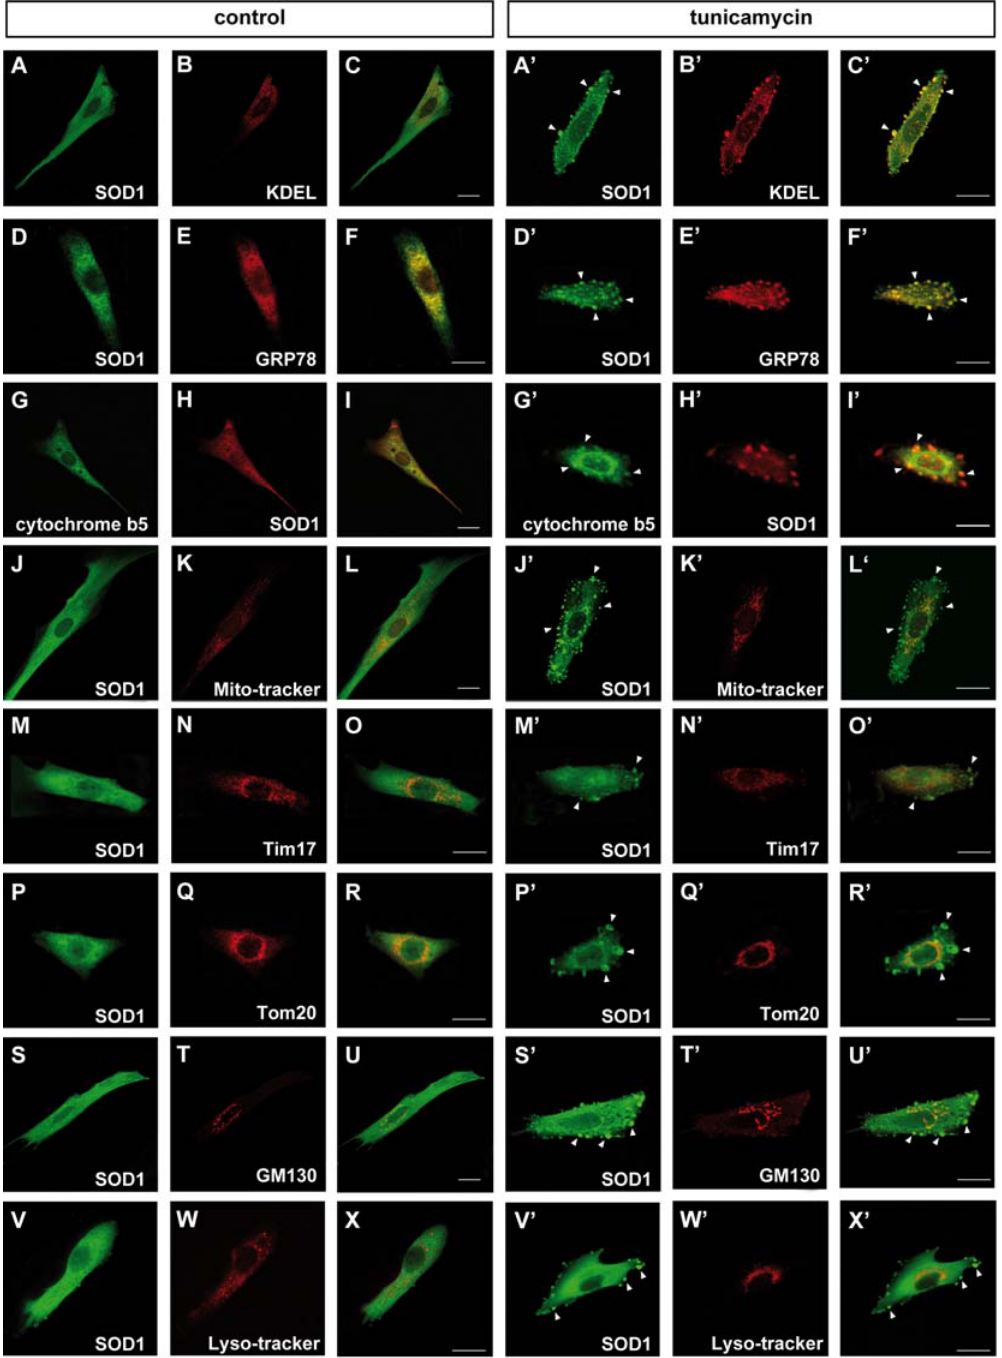
Figure 3. Positive translocation of SOD1 aggregates to ER, but not to the mitochondria, Golgi apparatus, or lysosomes. ( A–I, A 9 –I 9 ) Stress- dependent localization of SOD1 to the ER. L84V SOD1-expressing SK-N-SH cells were incubated for 24 h without ( A–I ) or with 1 m g/ml of tunicamycin ( A 9 –I 9 ). Then the cells were fixed and stained using an anti-SOD1 antibody (green; A, D, A 9 , D 9 ) and an anti-KDEL antibody (red; B, B 9 ) or an anti- GRP78/BiP antibody (red; E, E 9 ). GFP-cytochrome b5 were transfected to the cells and stained with anti-GFP (green; G, G 9 ) and anti-SOD1 (red; H, H 9 ) antibodies. Merged images ( C, F, I, C 9 F 9 , I 9 ). The aggregates of SOD1 (arrowheads) are positive for KDEL, GRP78/BiP and cytochrome b5. ( J–R, J 9 –R 9 ) Analysis of SOD1 localization to the mitochondria. L84V SOD1-expressing SK-N-SH cells were treated as described in above. The locations of the mitochondria and SOD1 were visualized in L84V SOD1-expressing SK-N-SH cells using 100 nM Mito-tracker (red; K, K 9 ), an anti-Tim17 antibody (red; N, N 9 ) or an anti-Tom20 antibody (red; Q, Q 9 ) and an anti-SOD1 antibody (green; J, M, P, J 9 , M 9 , P 9 ). Merged images ( L, O, R, L 9 , O 9 , R 9 ). ( S–U, S 9 –U 9 ) Investigation of SOD1 localization to the Golgi apparatus. L84V SOD1-expressing SK-N-SH cells were treated as described in above. Then the cells were stained with anti-SOD1 antibody (green; S, S 9 ) and anti-GM130 antibody (red; T, T 9 ). Merged images ( U, U 9 ). ( V-X, V 9 -X 9 ) Analysis of the localization of SOD1 to the lysosomes. A GFP-tagged L84V SOD1 vector was transfected into L84V SOD1-expressing SK-N-SH cells. After 24 h of incubation with 1 m g/ml of tunicamycin, the cells were incubated for a further 30 min with 100 nM Lyso-tracker (red; W, W 9 ) to visualize the lysosomes. GFP channel ( V, V 9 ) Merged images ( X, X 9 ). Scale bars=20 m m. Arrowheads indicate aggregated SOD1.